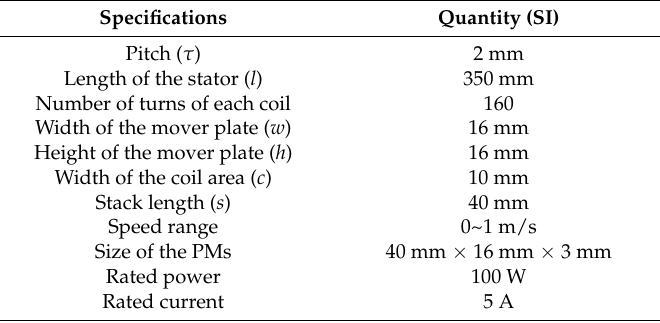
Figure 4. The main flow chart of the controller for the whole power generation system.